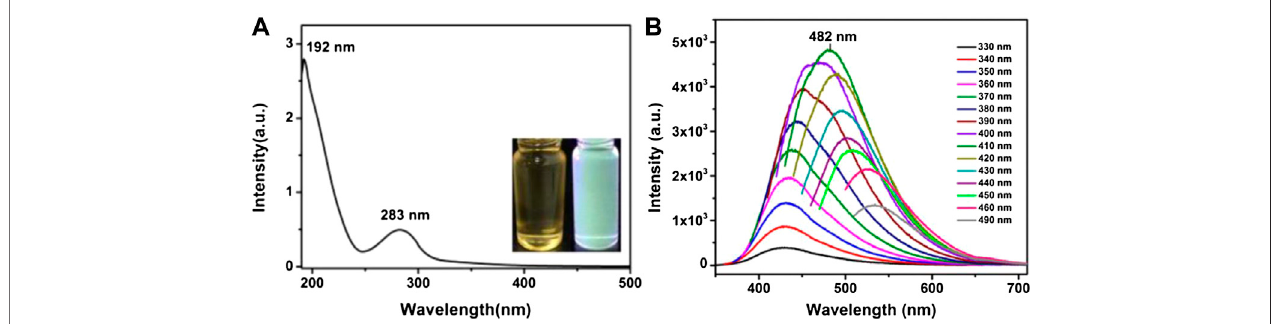
FIGURE 9 | (A) UV – Vis absorption spectra of CQDs, inset: optical images under daylight (left) and UV light (right). (B) PL spectra of CQDs at different excitation wavelengths. Reprinted with permission from He et al. (2018).